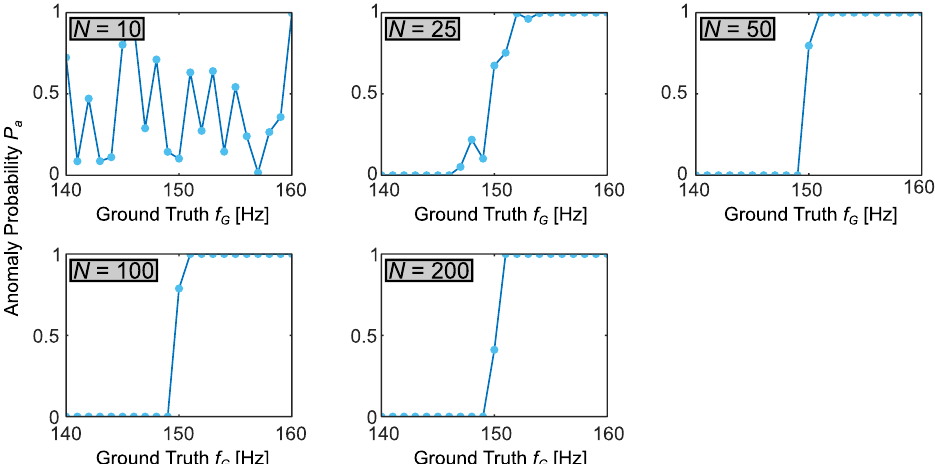
Figure 6. Anomaly detection curves for each sample number N . The anomaly probability P a is the Bayesian-inferred probability that the excitation frequency exceeds 150 Hz, plotted against the ground truth